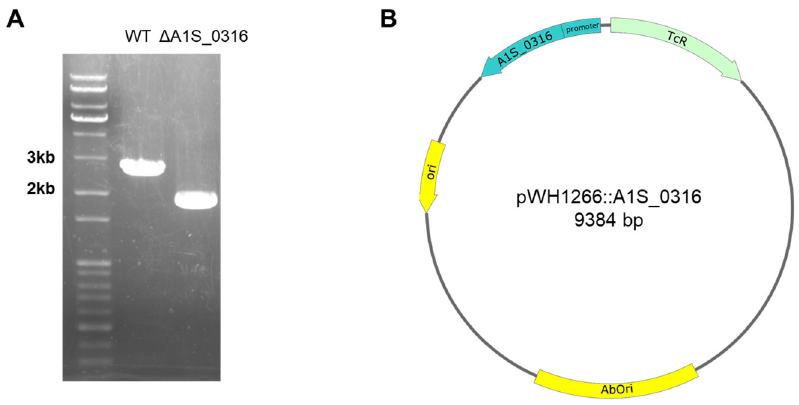
Figure 5. The markerless gene-editing method used for constructing the A. baumannii Δ A1S_0316 mutant ( A ). The DNA-stained 1% agarose gel shows that the length of A1S_0316 nearby DNA sequence was shorter than that of the wild-type strain ( A ). To complement the mutant strain, pWH1266: A1S_0316 including its promoter was constructed ( B ).